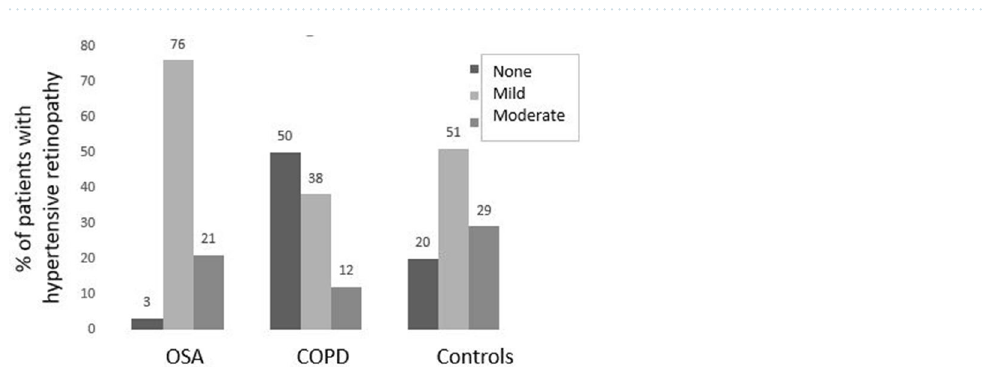
Figure 1. Retinal imaging demonstrating. ( A ) Mild microvascular retinopathy with arteriole (A) and vein and arteriovenous nicking (black arrow); and ( B ) moderate microvascular retinopathy with further examples of microvascular nicking (black arrows) and likely haemorrhage (white arrow).